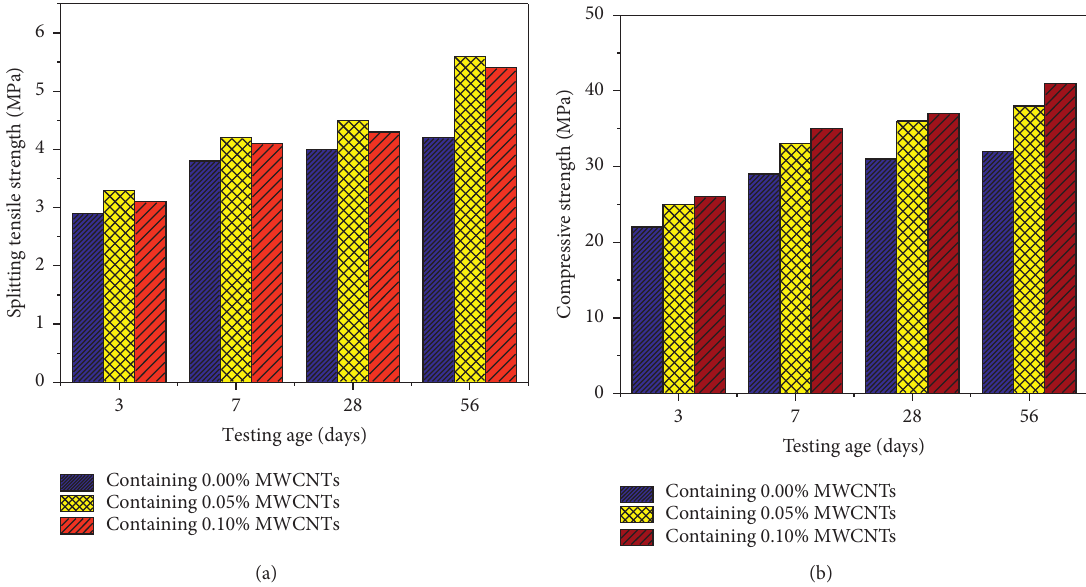
Figure 16: . (a) Splitting tensile strength and (b) compressive strength of concrete with different contents of MWCNTs at different ages [96].